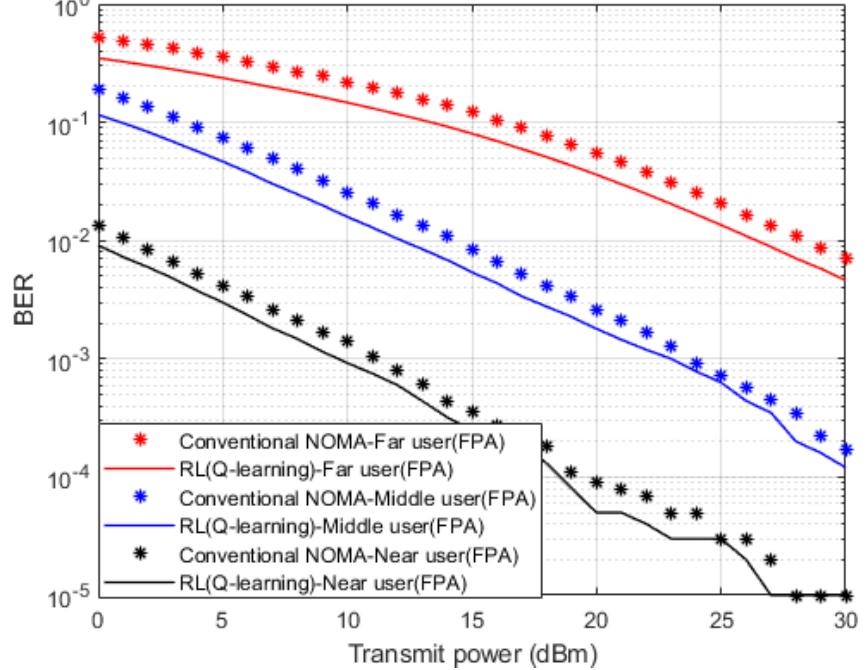
Figure 4. BER vs. power ( Q ‐ learning & Conventional NOMA (MMSE)).